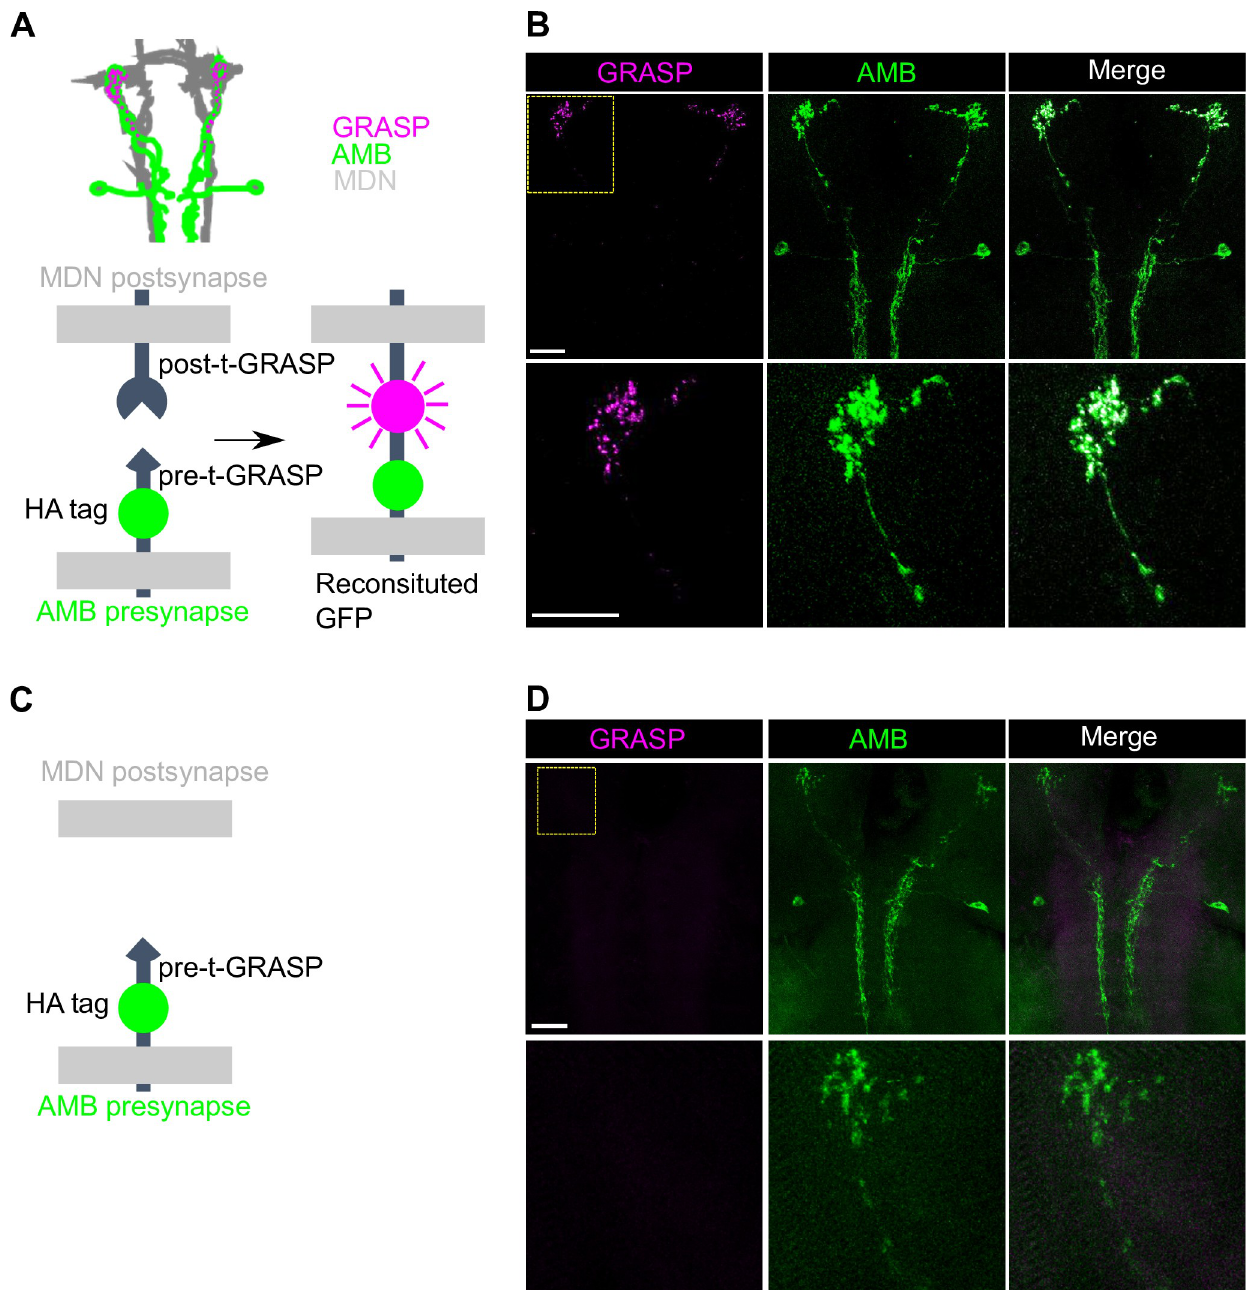
Fig 5. GRASP analysis of physical contacts between AMBs and MDNs. (A) A schematic view of t-GRASP between AMBs and MDNs. spGFPs located in each site of the synapse are reconstituted only when two membranes are close enough to make contacts. (B) GRASP signals between AMBs and MDNs were observed the area where AMB axons were co-localized with MND dendrites in the brain. (C) A schematic view of t-GRASP between AMBs and MDNs without expression of the post-t-GRASP fragment in MDNs. (D) No detectable GRASP signals were observed in the brain without expression of the post-t- GRASP fragment in MDNs. The yellow dot square in the upper row is magnified in the lower row. AMBs are labeled by anti-HA. Genotypes: w ; R60F09-LexA /+; R73F04-GAL4 , Gad1-2A-GAL80 / UAS-post-t-GRASP , pre-t-GRASP . Scale bars, 20 μ m.